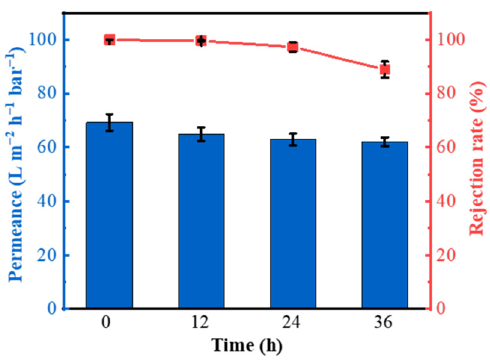
Figure 4. Effect of AH-rGO membranes on water permeance and rejection rates of 50 mg/L CoCl 2 solution with different filtration times.